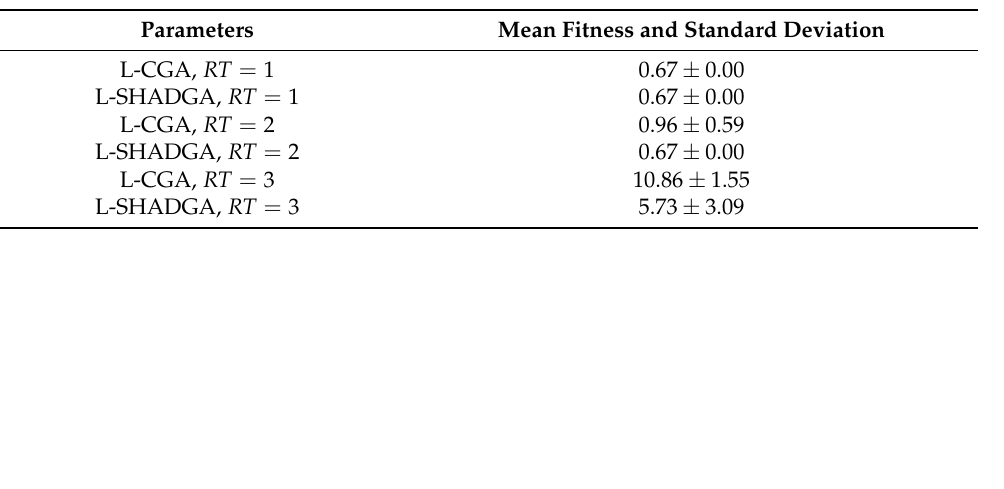
Table 2. Experimental results for 3-mode micrsostrip